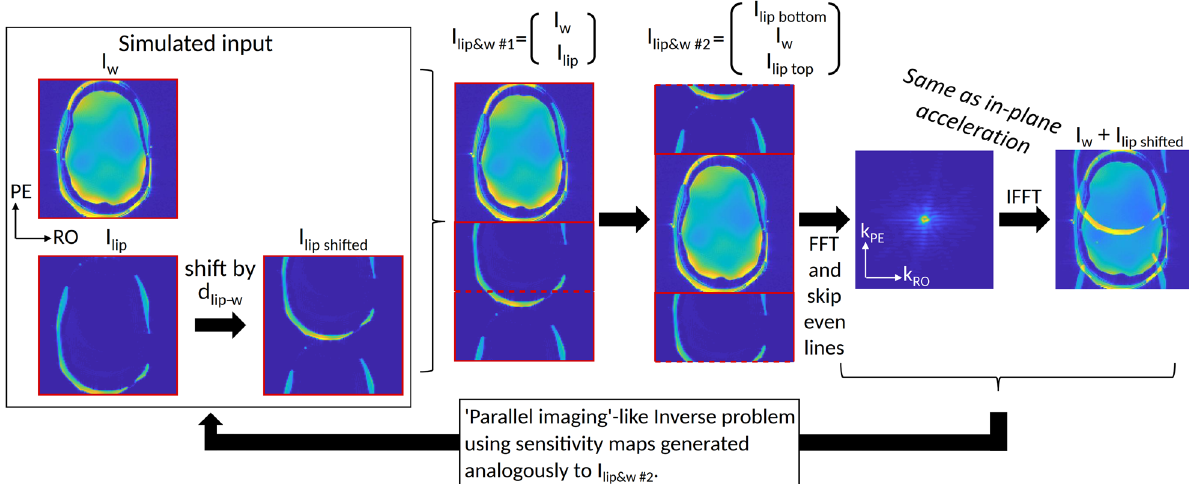
Figure 1. Extended formulation that can combine three parallel imaging aspects (1) in-plane PE acceleration, (2) SMS acceleration and (3) lipid-water separation. The steps show how a resulting EPI image can be described for water and lipid “slices” (I w and I lip ). The I w and I lip shifted are concatenated, then shifted together by a half- FOV. Images “I w + I lip shifted ” (at the far right) and “I lip&w #2 ” resemble the case of in-plane acceleration, with “I w + I lip shifted ” analogous to the acquired image (due to sub-sampling) and “I lip&w #2 ”analogous to the full-FOV image in such a case. Following this description, one can solve the inverse problem analogous to in-plane parallel imaging using sensitivity maps. The same description holds also for two slices acquired simultaneously (instead of lipids and water signals). Finally, the formulation can be extended to any number of slices and fat/ water